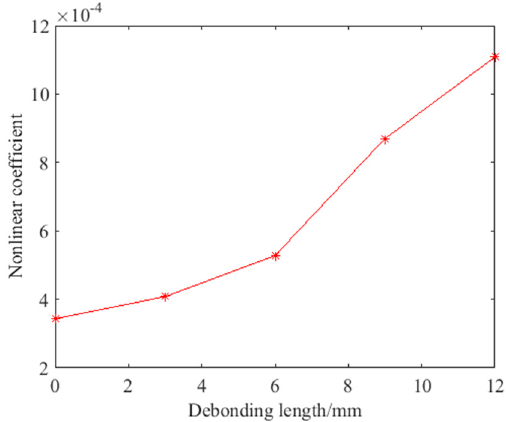
Figure 11. The variation curves of the nonlinear coefficient under different debonding states.